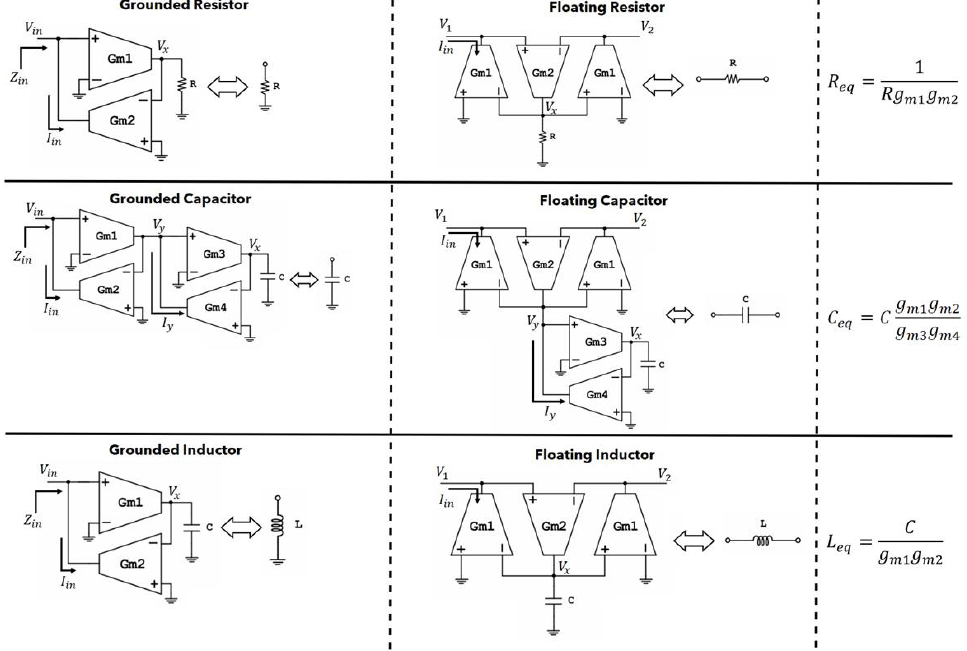
(12) Figure 8. ( a ) Lossless integrator, ( b ) Lossy integrator with element replacement. Replacing the resistor of the lossy integrator by an OTA-based equivalent grounded resistor (Figure 8b) results in a lossy integrator with an adjustable gain, K :